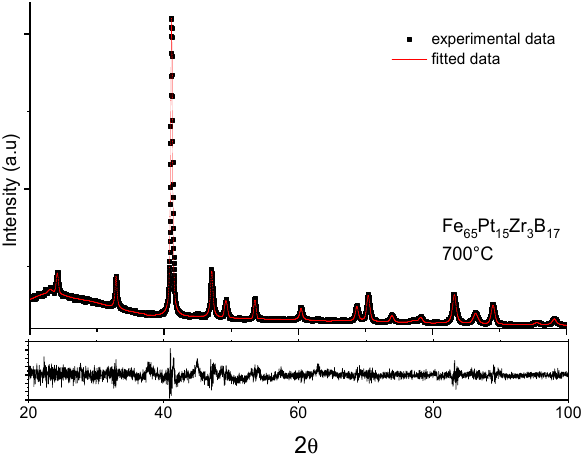
Figure 5. MAUD fitting of the XRD diagram of the sample annealed at 700 ◦ C for 30 min. Figure 5: MAUD fitting of the XRD diagram of the sample annealed at 700 °C for 30 min. Table 1. Lattice parameters, ordering parameter and grain sizes for the as-cast and annealed Fe 65 Pt 15 Zr 3 B 17 samples. Sample